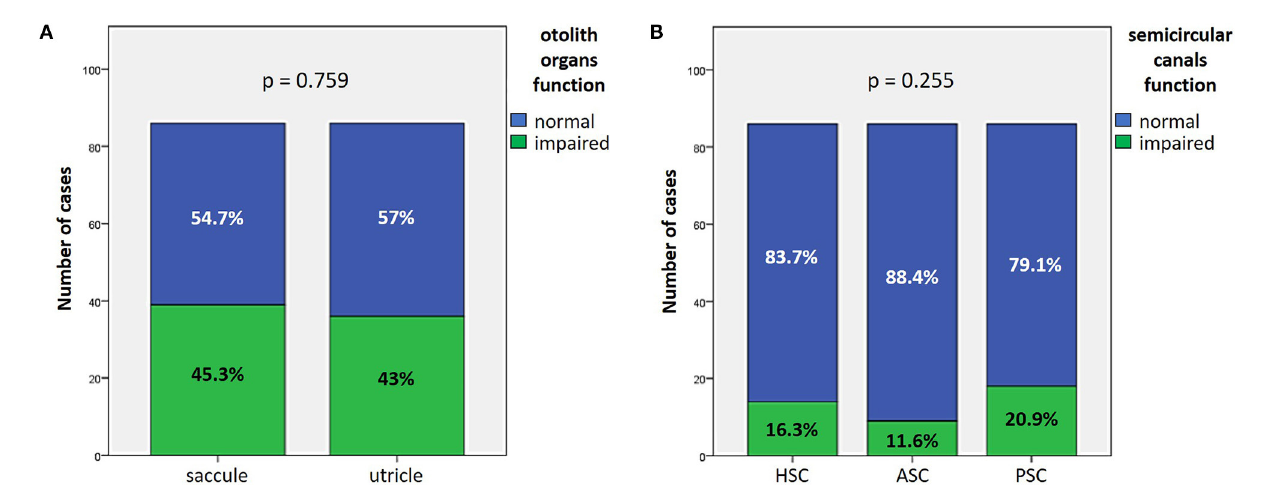
FIGURE1 Bar plots showing the number of cases among overall cohort of 86 cases exhibiting different instrumental findings. (A) Normal or impaired function of otolith receptors. (B) Normal or impaired function of semicircular canals. Relative percentages are reported in each column and p -values of categorical comparisons are reported. ASC, anterior semicircular canal; HSC, horizontal semicircular canal; PSC, posterior semicircular canal.